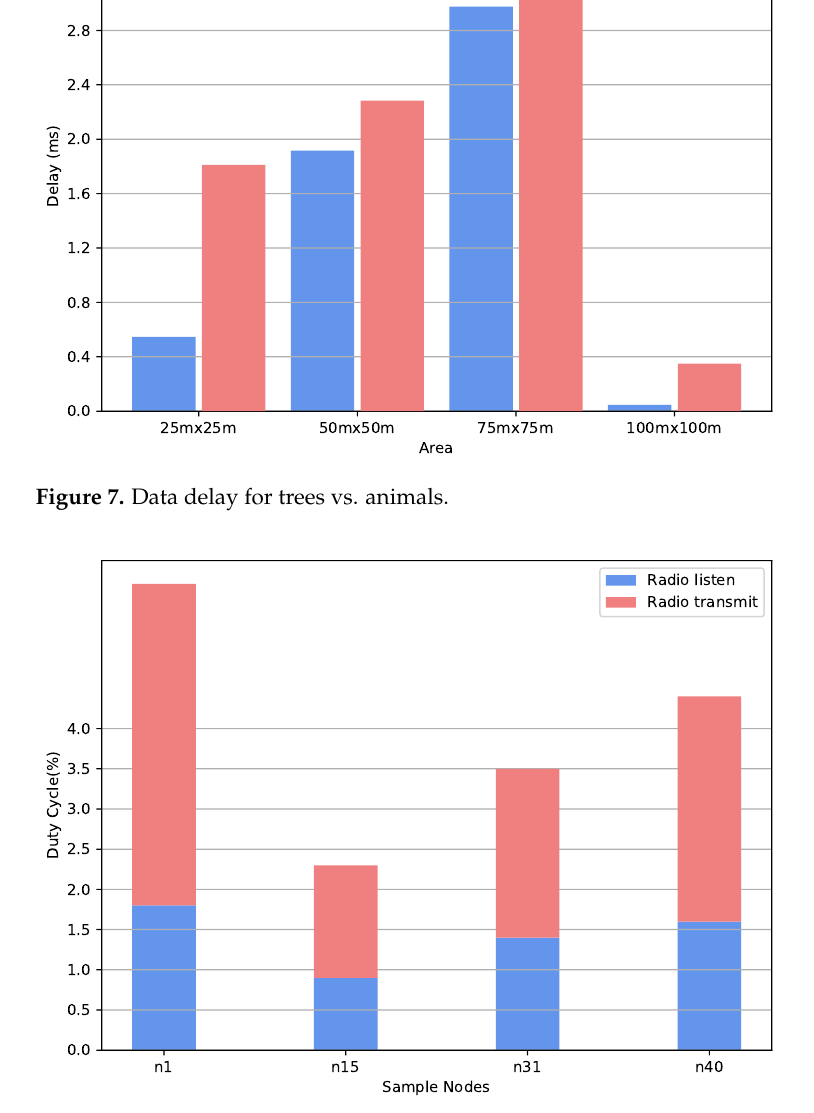
Figure 8. Duty Cycle Percentage for Random nodes = [1, 15, 31, 40]. Table 5. Network Connectivity Parameters. Scenario Trees